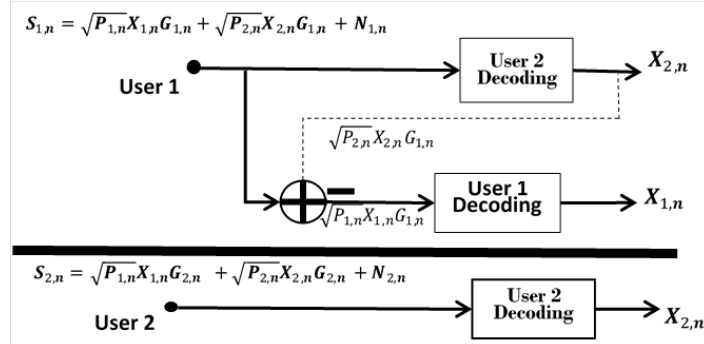
Figure 2. SIC application in NOMA for each multiplexed user.